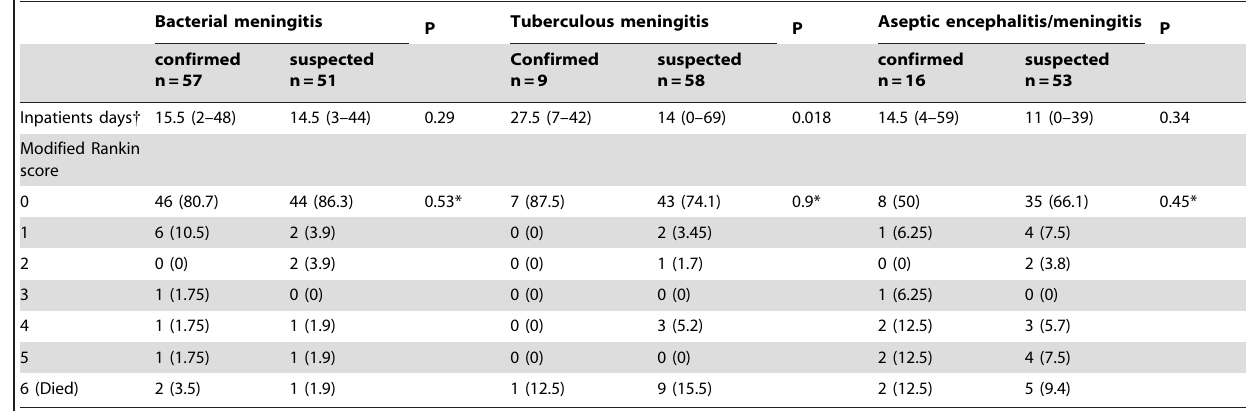
Table 4. Patient